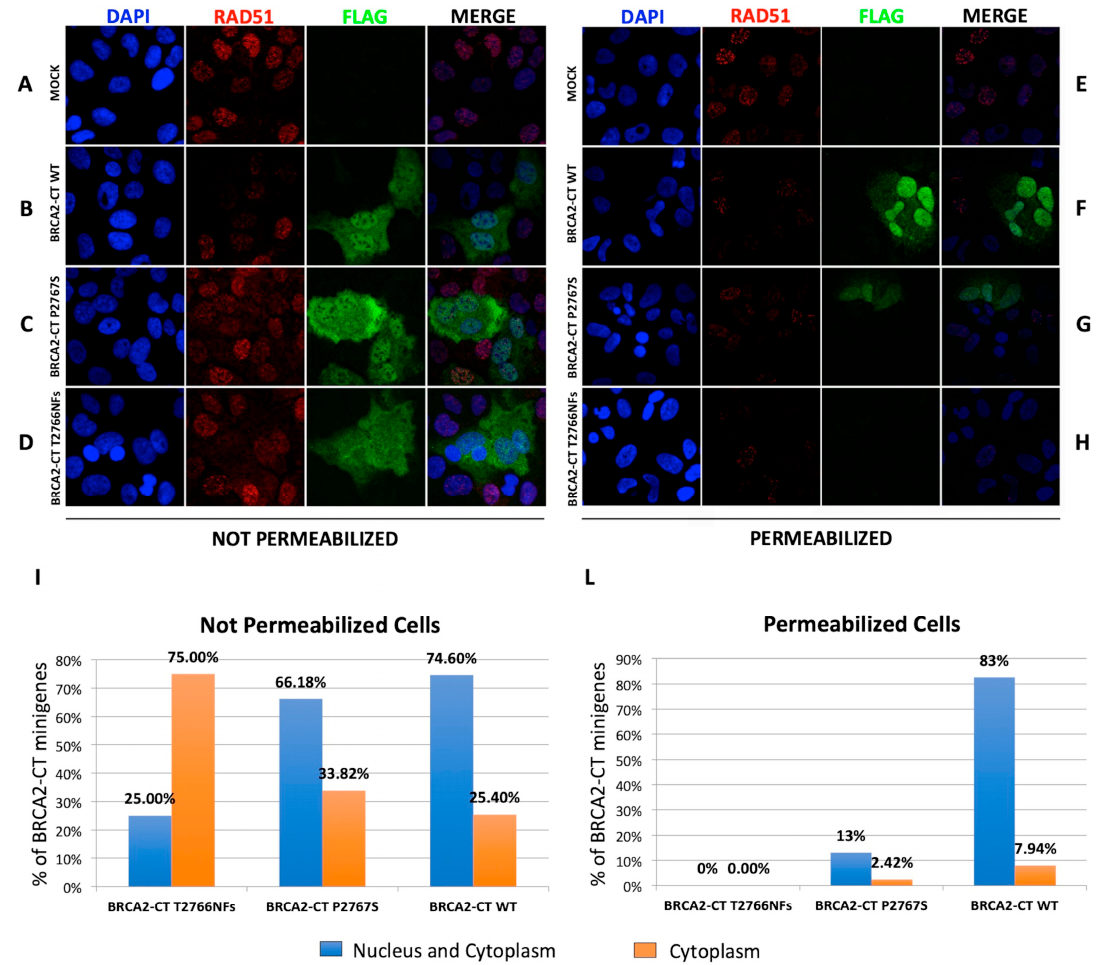
Figure 5. The analysis of the binding of nuclear BRCA2-CT proteins to chromatin by immunofluorescence in U2OS cells. ( A ) Not permeabilized U2OS mock cells and U2OS cells transfected with ( B ) BRCA2-CT wt, ( C ) BRCA2-CT P2767S and ( D ) the BRCA2-CT T2766NFs minigenes. The nuclear localization of ectopically expressed FLAG-tagged proteins is shown in green. Scale bars: 0.22 µ m. ( F ) Permeabilized mock cells did not generate any signal. Conversely, in permeabilized U2OS cells transfected with ( F ) BRCA2-CT wt, with ( G ) BRCA2-CT P2767S and with ( H ) the BRCA2-CT T2766NFs minigenes, only the BRCA2-CT wt protein was detected, whereas the BRCA2-CT P2767S and BRCA2-CT T2766NFs proteins were predominantly washed out during the permeabilization procedure. ( I ) Percentage of transfected cells showing predominantly nuclear, nuclear and cytoplasmic and cytoplasmic-only BRCA2-CT staining before the permeabilization procedure. In Figure 5I,L the Y-axis represents the percentage of BRCA2-CT minigenes that localize predominantly both in the nucleus and in the cytosol or only in the cytosol. All constructs showed a principally nuclear and cytoplasmic localization. In particular, without permeabilization, the BRCA2-CT WT and the BRCA2-CT P2767S predominantly localized in the nucleus (74.60% and 66.18% respectively), while the BRCA2-CT T2766NFs was principally in the cytoplasm (75% with respect to 25% of nuclear staining). ( L ) The quantification of BRCA2-CT proteins localization, after the permeabilization procedure, calculated on the total FLAG-expressed cells for each BRCA2-CT sample. Prevalently, 83% of the BRCA2-CT WT protein was nuclear-localized, while only 13% of the BRCA2-CT P2767S was found in the nucleus, and no BRCA2-CT T2766NFs was detected in either the nucleus or the cytoplasm.